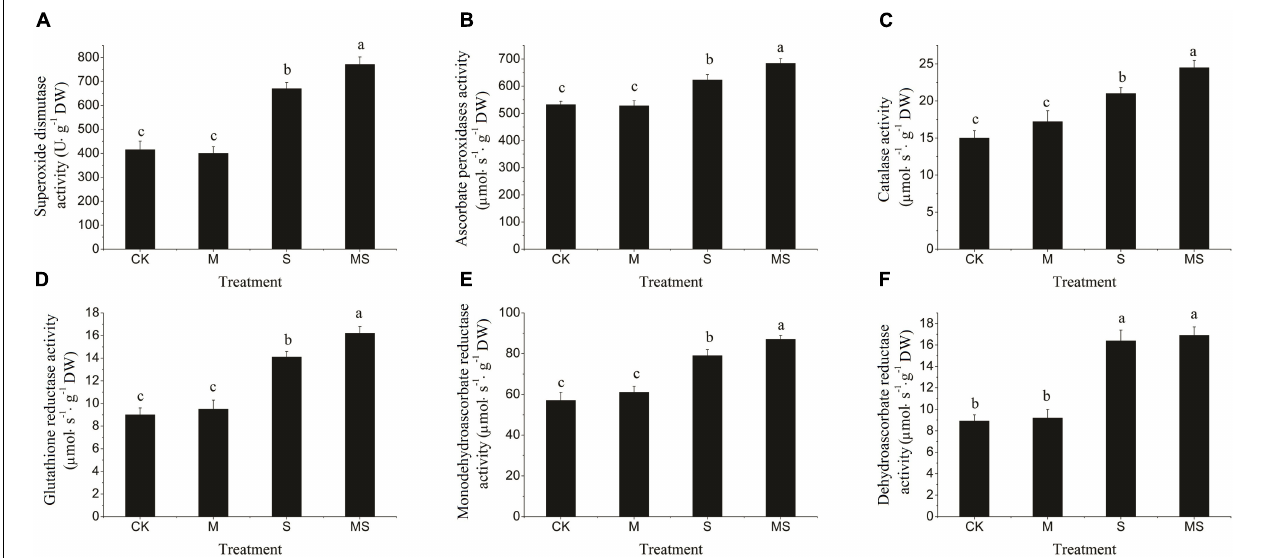
FIGURE 3 | Reactive oxygen species scavenging enzymes (SOD, APX, CAT, GR, MDHAR, and DHAR) in watermelon inoculated or non-inoculated seedlings with AMF Funneliformis mosseae and subjected or not to salinity-alkalinity stress. (A) SOD activity; (B) APX activity; (C) CAT activity; (D) GR activity; (E) MDHAR activity; (F) DHAR activity. ROS, relative oxygen species; SOD, superoxide dismutase; APX, ascorbate peroxidases; CAT, catalase; GR, glutathione reductase; MDHAR, monodehydroascorbate reductase; DHAR, dehydroascorbate reductase; AMF, arbuscular mycorrhizal fungi; CK, without AM inoculation + without salinity-alkalinity; M, with AM inoculation + without salinity-alkalinity; S, without AM inoculation + with salinity-alkalinity; and MS, with AM inoculation + with salinity-alkalinity. Values are means ± standard errors ( n = 10). Bars with different letters are significantly different at the 0.05 level (Duncan’s multiple range test).